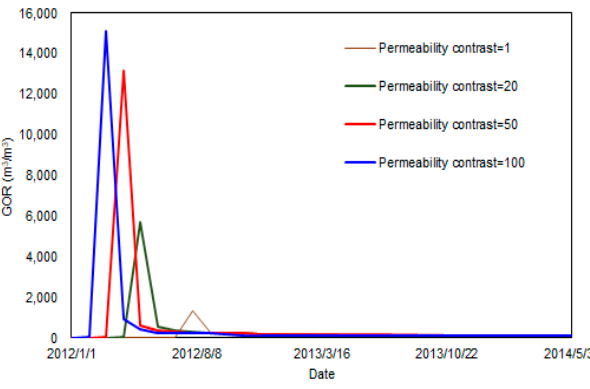
Figure 13. Channel level difference to the GOR of well